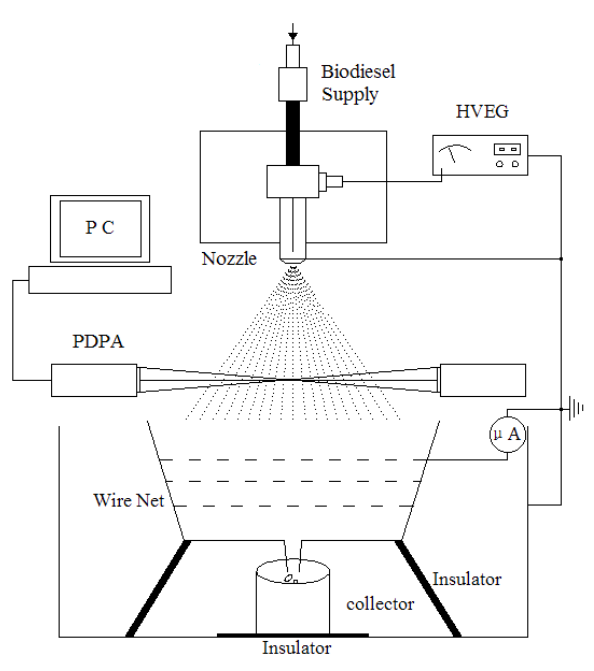
Figure 8. Electrodes, PDPA and the Faraday